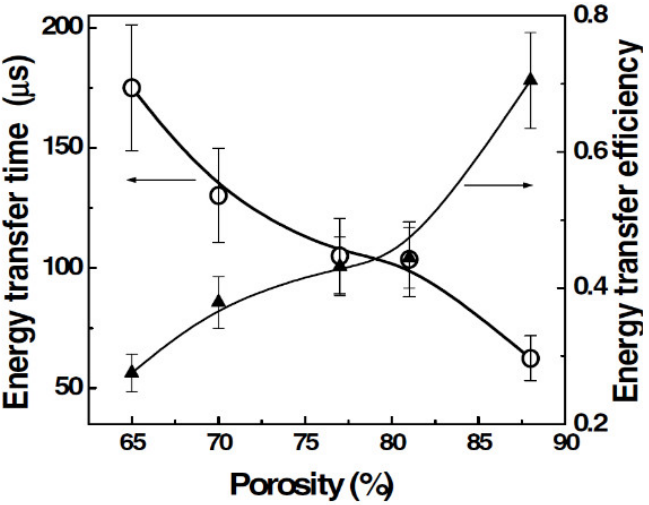
Figure 29. Energy transfer time (circles) and energy transfer e ffi ciency (triangles) vs porosity of por-Si. E exc = 3.7 eV, h ν PL = 1.6 eV, P ox = 1 bar, T = 300 K. (Reprinted from Reference [83] by permission from John Wiley and Sons © 2007).